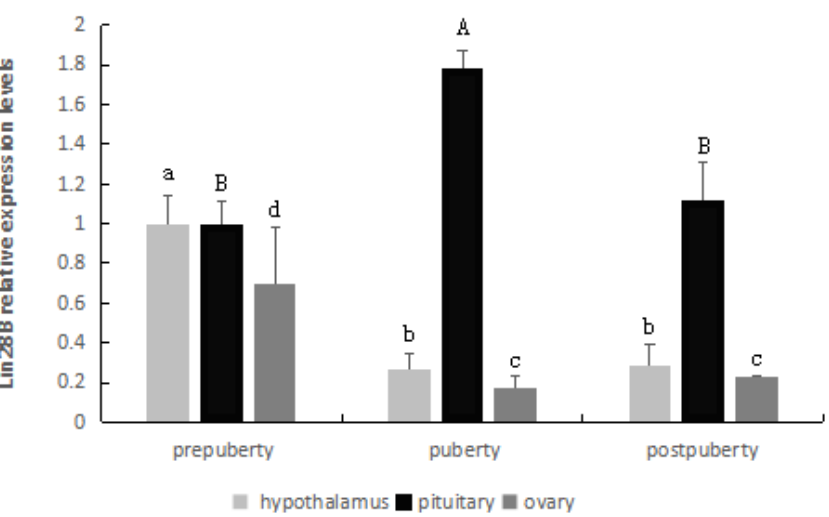
Figure 4. LIN28B relative mRNA levels in the hypothalamus, pituitary and ovary. Different letters above the bars in the same tissue indicate significant differences (p<0.05). LIN28B, lin-28 homolog B.